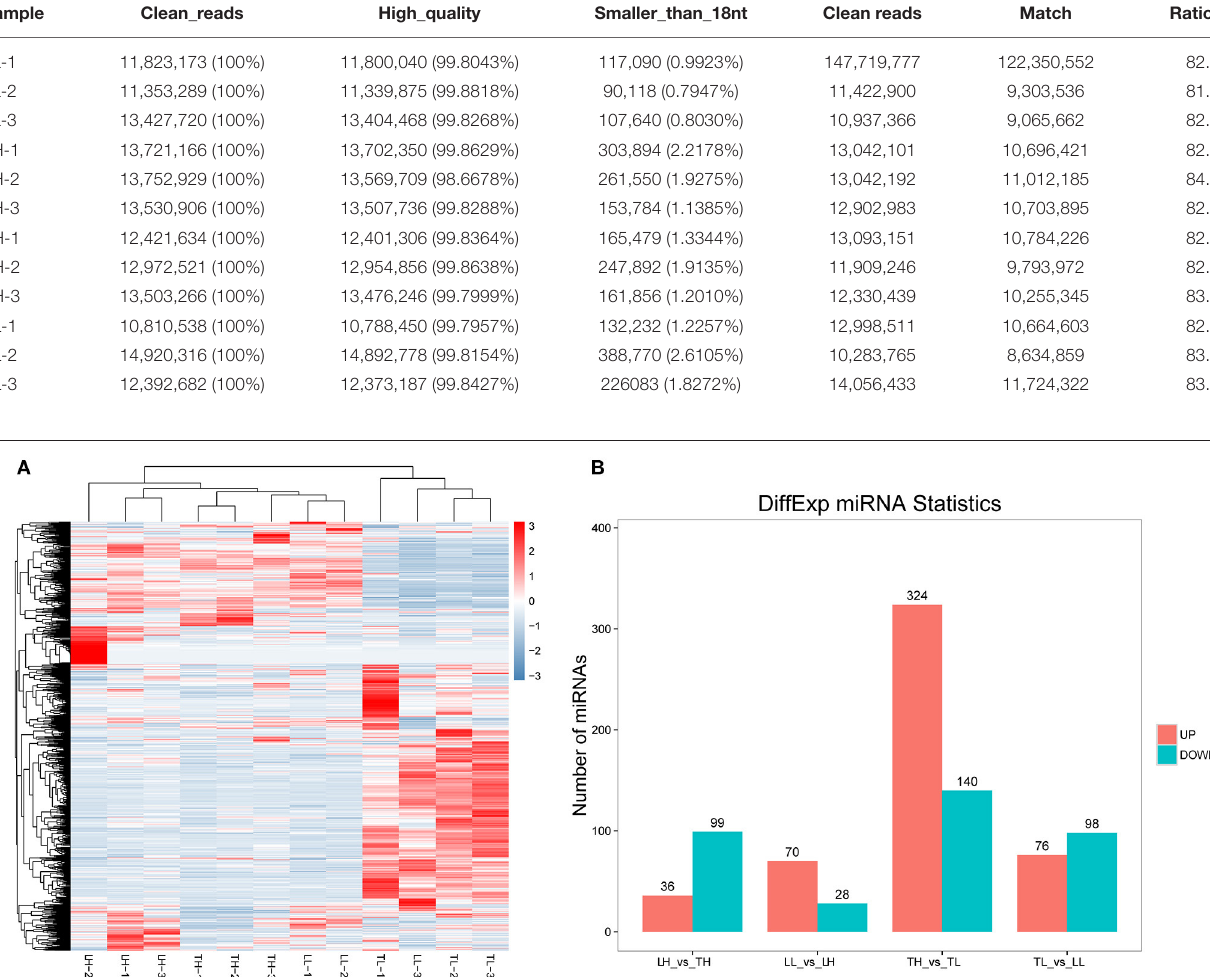
TABLE 2 | Overview of the reads and quality control of the 12 libraries of the miRNA sequencing from swine lung tissue. Sample